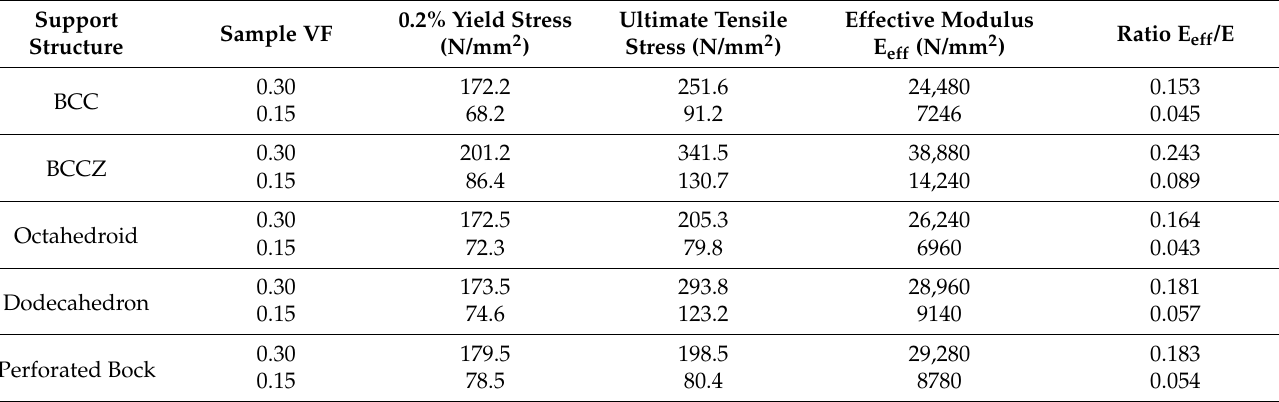
Figure 13. Stress–strain curve of Lattice support test specimen, printed with 0.3 volume fraction. Table 3. Mechanical properties of support structures.